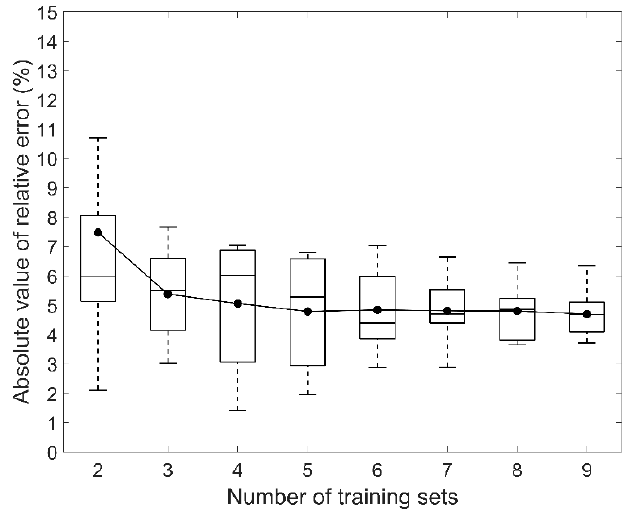
Figure 6. Sensitivity analysis between the number of training sets, and the average absolute value of the relative error between predicted and tested the compressive strength of group 6.